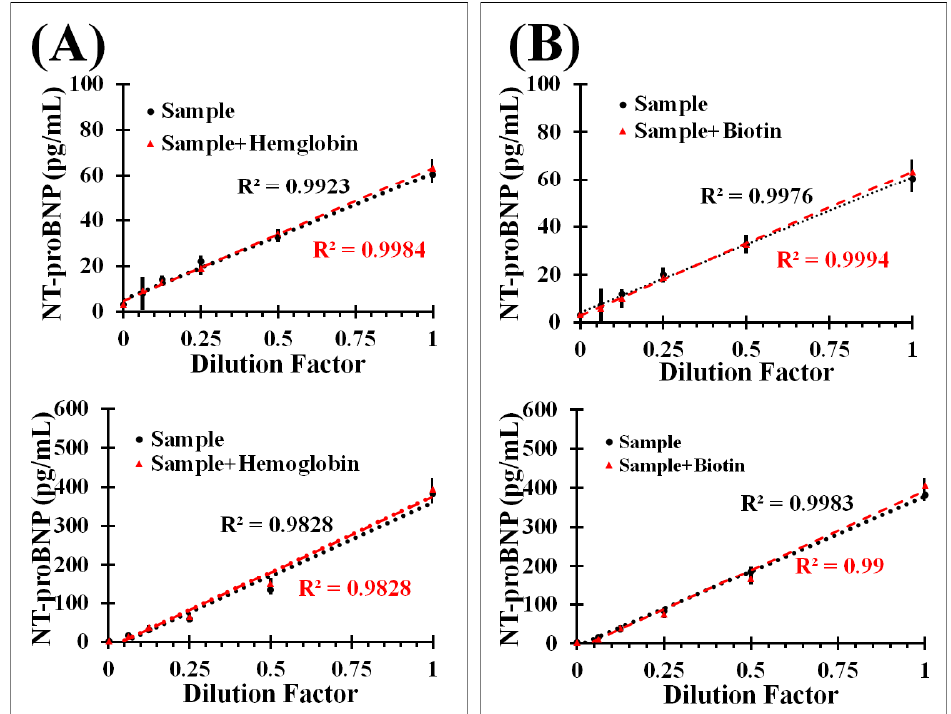
Figure 4. Determination of interference of ( A ) haemoglobin (1 mg/mL); ( B ) biotin (30 ng/mL) in clinical samples containing 60 pg/mL (top) and 400 pg/mL (bottom) of NT-proBNP.